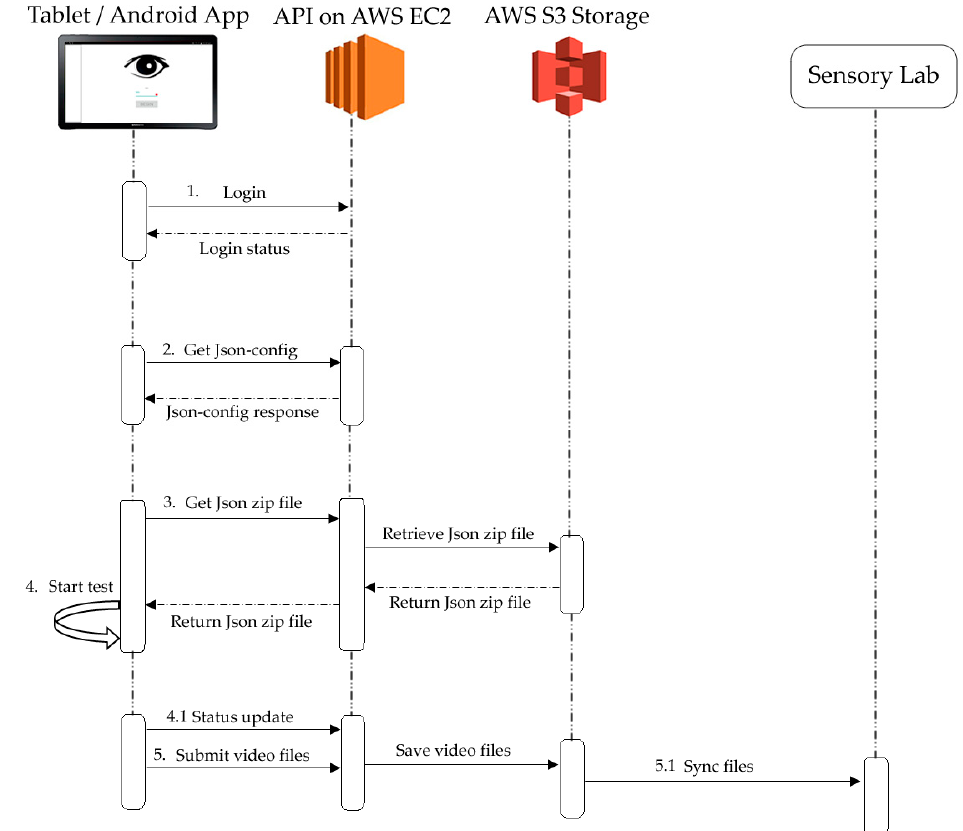
Figure 2. Diagram showing how the integrated system works through the Cloud. Abbreviations: AWS = Amazon Web Service, API = Application Program Interface, EC2 = Elastic Compute Cloud, Json = JavaScript Object Notation.